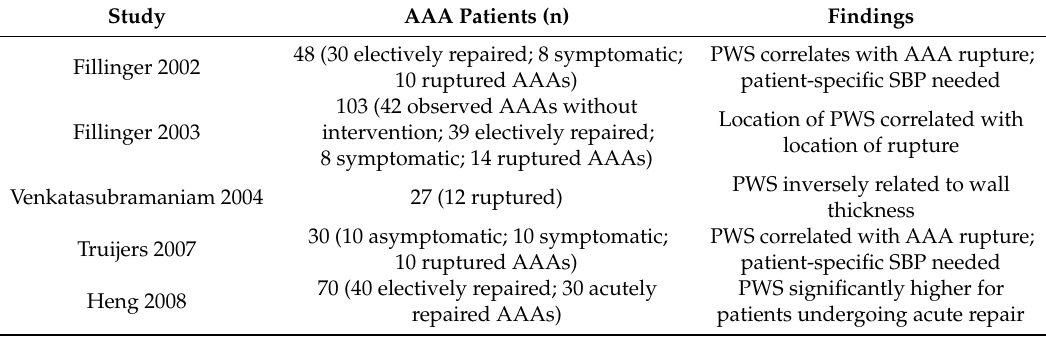
Table 1. Initial pioneering biomechanical studies on AAA. These studies have all used patient-specific AAA geometries extracted from CT scans, and modeled the AAA using shell elements in FEA. They further assumed constant wall thickness, the material properties described by Equation (4), and did not include an intraluminal thrombus